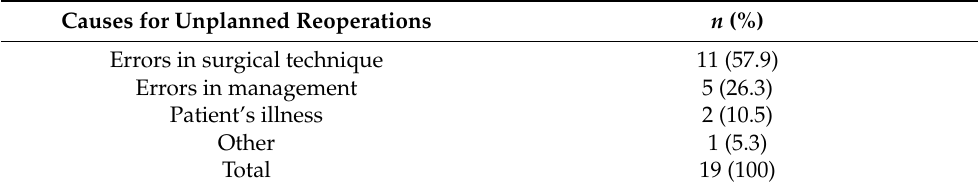
Table 7. Causes for uROR in the 30-day postoperative